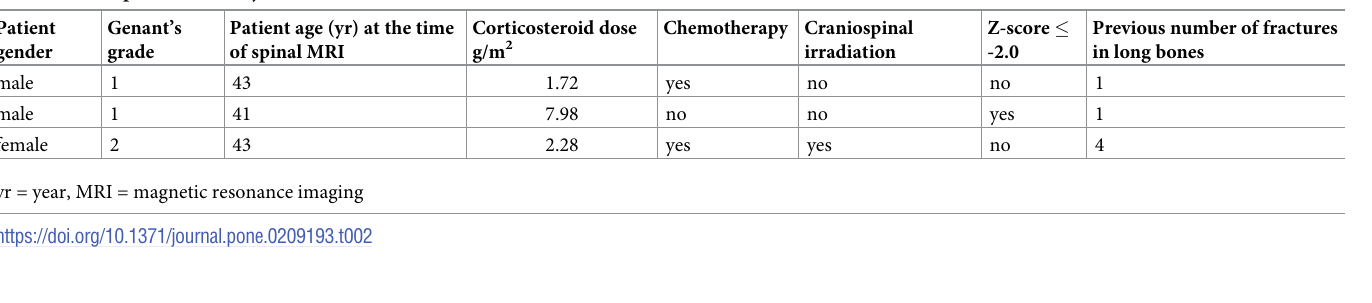
Table 2. Description of the subjects who had vertebral fractures.